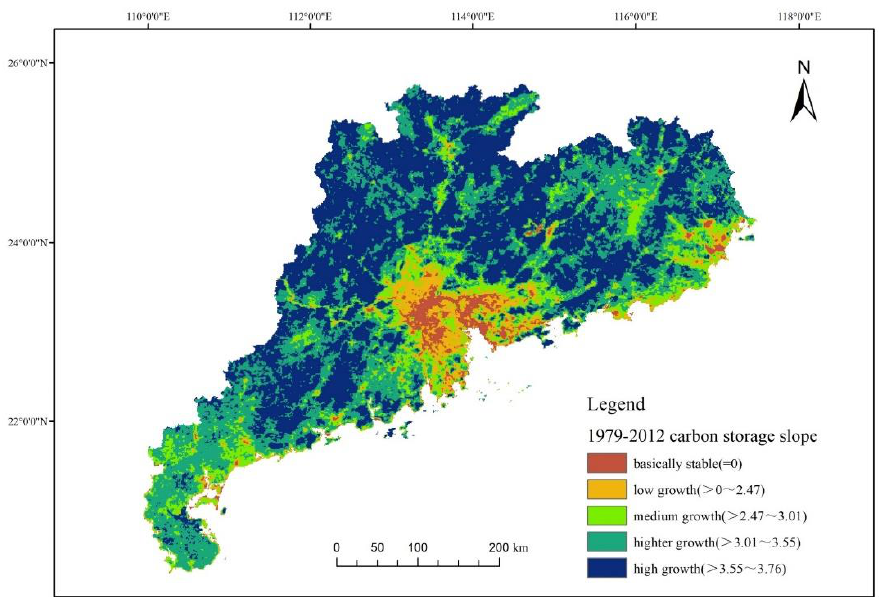
Figure 4. Temporal changes of carbon storage in Guangdong Province from 1979 to 2012.